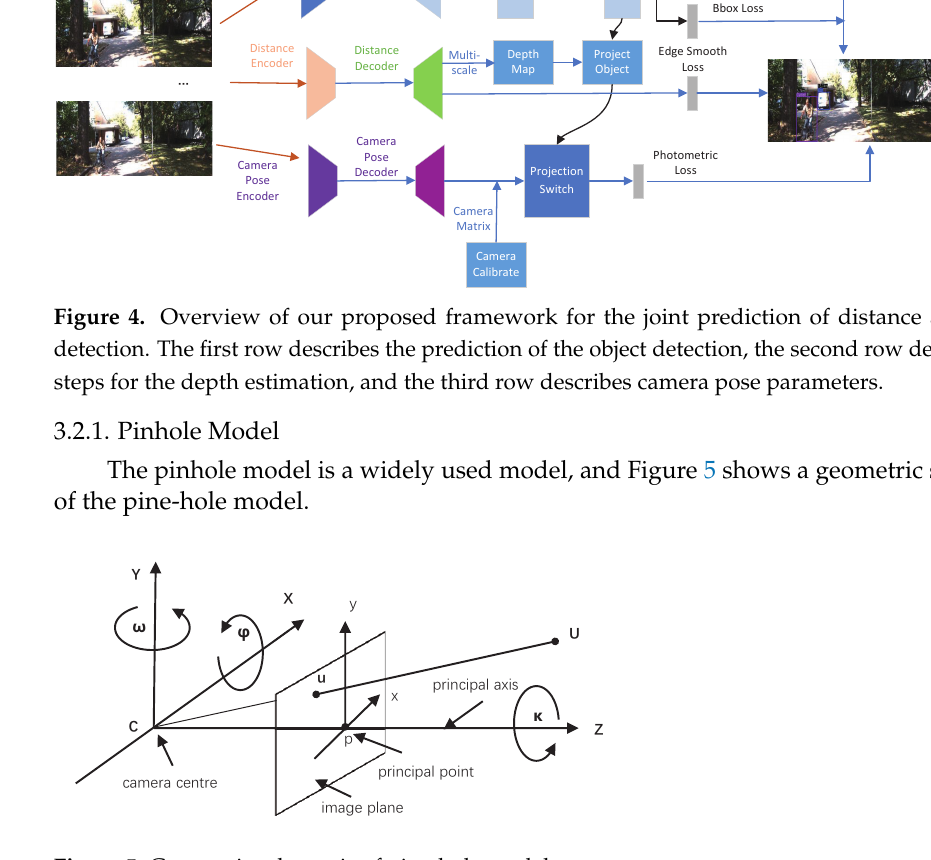
Figure 5. Geometric schematic of pine-hole